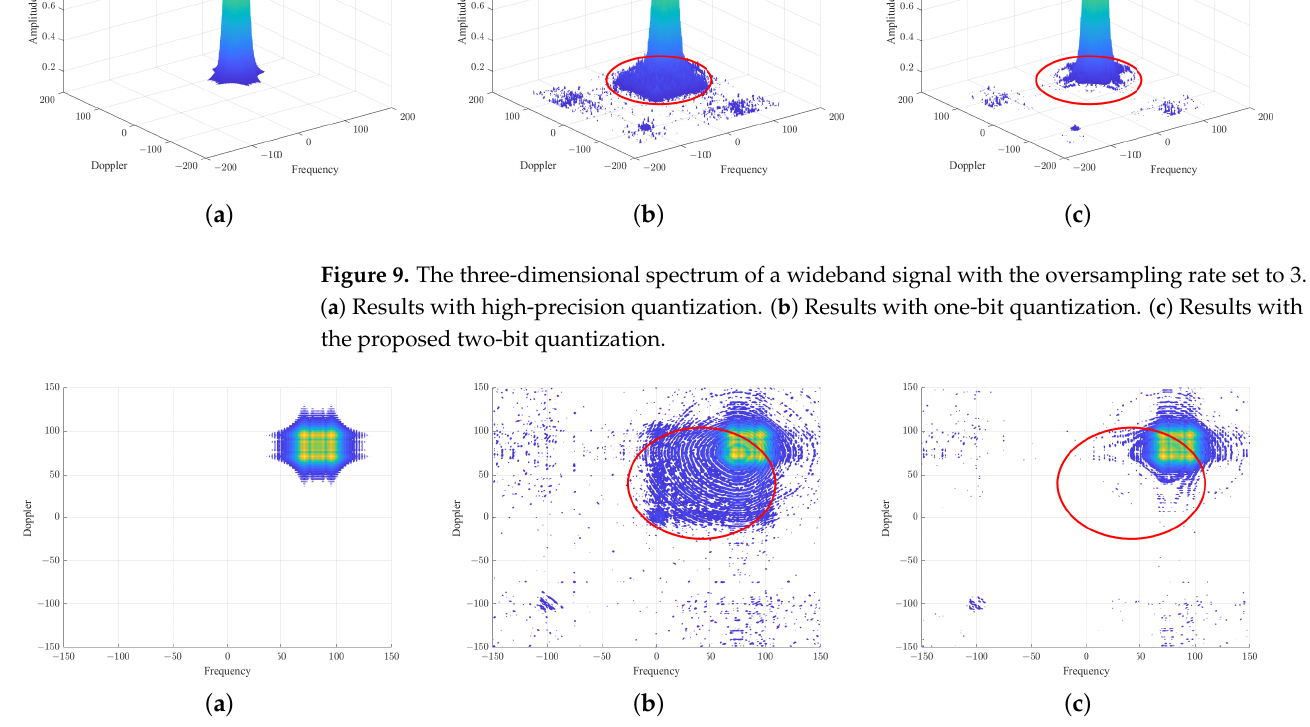
Figure 10. The two-dimensional spectrum of a wideband signal with the oversampling rate set to 3. ( a ) Results with high-precision quantization. ( b ) Results with one-bit quantization. ( c ) Results with the proposed two-bit